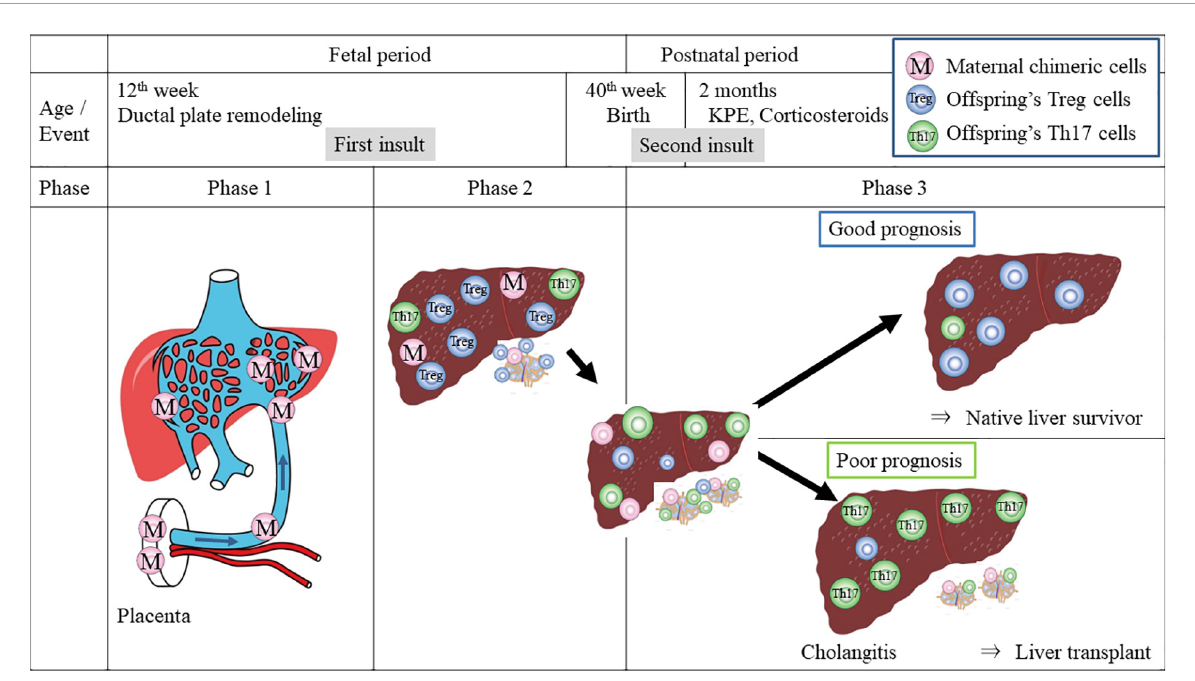
FIGURE3 Hypothetical model of T-cell dynamic imbalance in pathogenesis of BA. Phase 1 is the first insult: maternal effector T cells which transfer via the umbilical vein largely into the left lateral segment of the fetal liver may damage the developing ductal plate and the portal vein structure during the first trimester. Maternal chimeric cells persist in the liver and the secondary lymphoid tissues. Phase 2 describes the remainder of gestation. Fetal Tregs become dominant in peripheral lymphoid organs and in the liver, suppressing autoreactive Th17 cells and allowing pregnancy stability. Phase 3 is the postnatal period. At birth, due to lack of lithocholic acid in the gut of patients with BA, Th17 differentiation and Treg cell deficit may occur and the balance turns into chronic GVHD-type autoimmunity under activated inflammatory cytokines such as IL-6 and IL-8. Even after bile drainage is achieved with KPE and immune imbalance may be reversed with corticosteroids, persistent maternal chimeric cells may continue to skew immunity toward autoreactivity, causing a flare-up of inflammation, leading to frequent episodes of cholangitis and ongoing liver fibrosis. In contrast, with the elimination of maternal chimeric cells, the patients may have a chance to become anicteric with normal liver function and achieve long-term